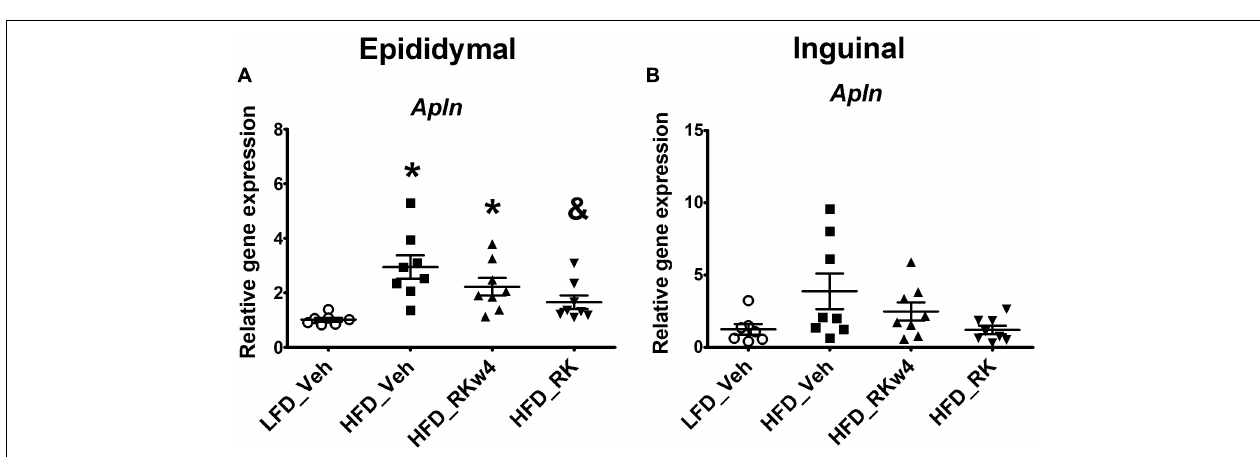
FIGURE 5 | Relative gene expression for apelin ( Apln ) in epididymal (A) and inguinal (B) adipose tissue for mice with RK (200 mg/kg) or vehicle daily dosing for a period of 12 weeks. All gene expression data were expressed as an n-fold difference relative to the mean of the LFD group. Data are represented as mean ± SEM. * p < 0.05 vs. LFD_Veh and & p < 0 . 05 vs HFD_Veh; One-way ANOVA followed by Newman Keuls post hoc analysis ( n = 7 for LFD_Veh; n = 8 per HFD